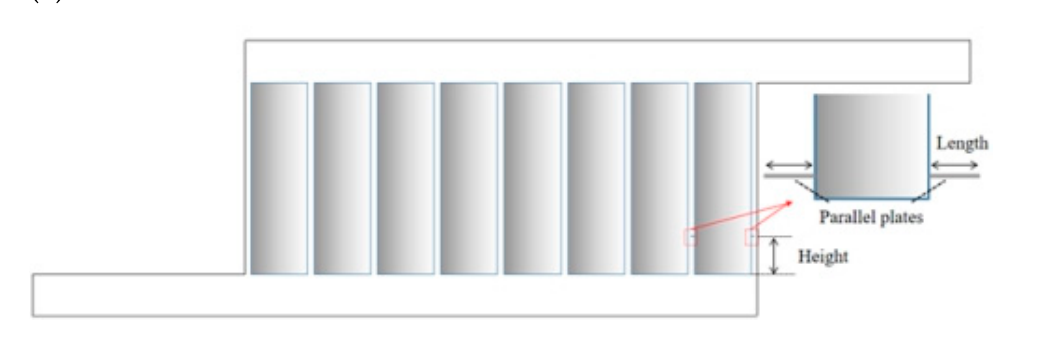
Figure 2. Battery thermal management system (BTMS) with two parallel plates; ( a ) 3D example of adding two parallel plates; ( b ) 2D example of adding two parallel plates.